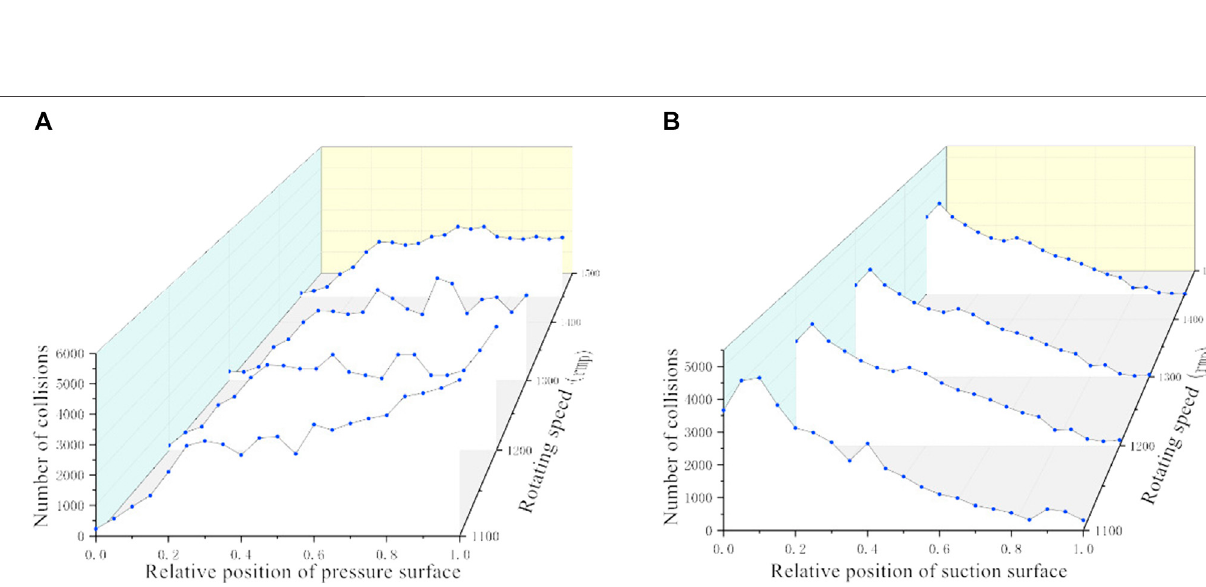
Frontiers in Energy Research |